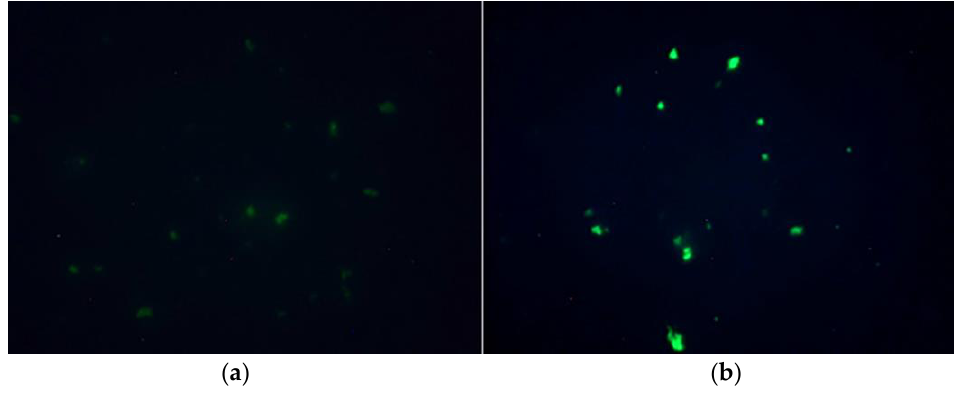
Figure 2. Fluorescence microscopy for ( a ) curcumin- and ( b ) mitocurcumin-treated bacteria.